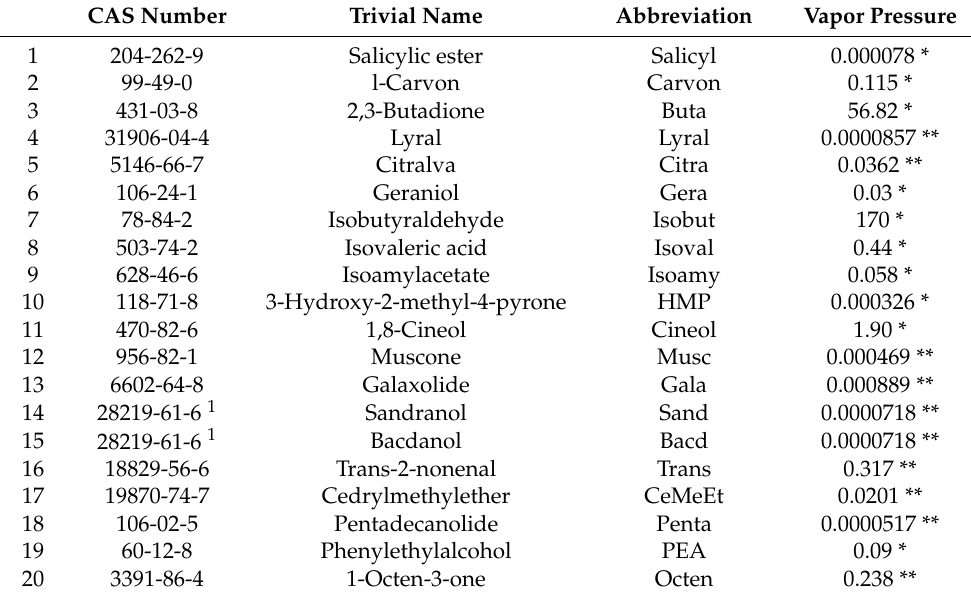
Table 1. Overview of Odors. Listed are CAS registry number, trivial name, abbreviation used in plots and graphs and vapor pressure estimations (in mmHg at 25 ◦ C; retrieved from PubChem * and ChemSpider **).